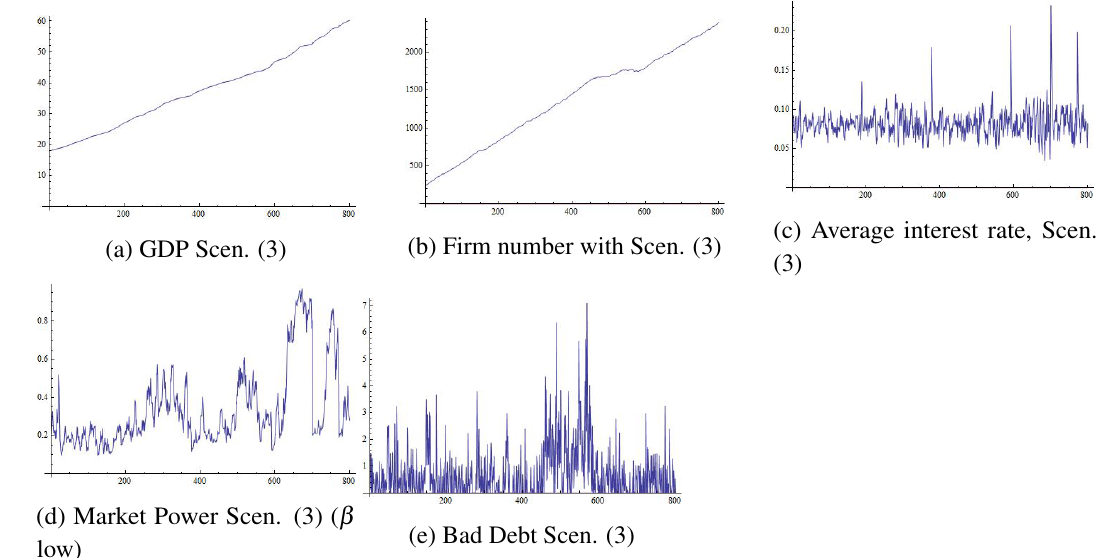
Figure 8: Uncorrelated stock prices ( β low)